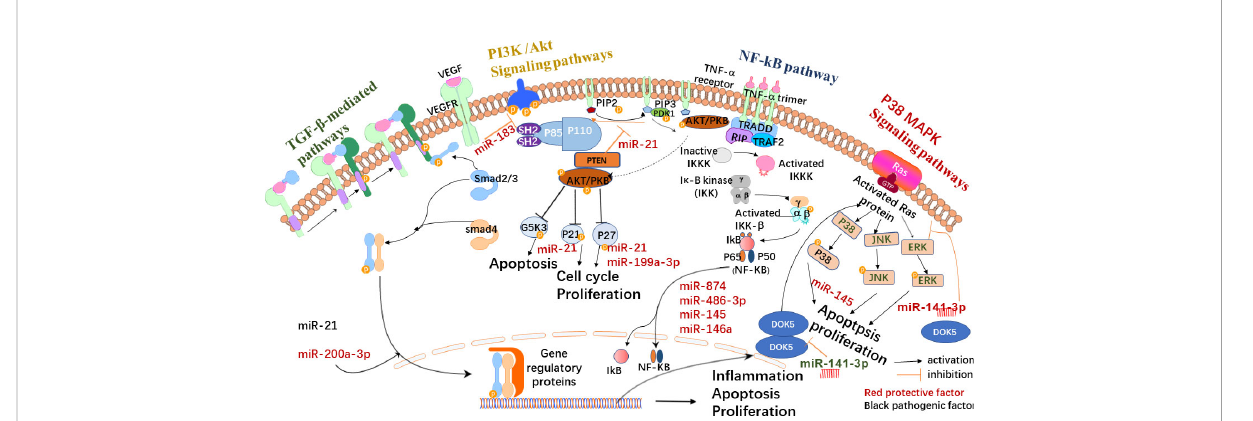
FIGURE 2 Possible exosome-mediated signaling pathways in DR. Exosomes are synthesized in various cells. Under physiological or pathological conditions, their carriers may change and participate in the formation of the collective pathological state. They may activate TGF- b , the signaling pathway that mediates the hemodynamics of individuals with PDR. By blocking TGF- b , the activation of the signaling pathway promotes cell proliferation and reduces apoptosis and the in fl ammatory response. Exosomes (such as miR-141-3p) may also inhibit retinal neovascularization by preventing the activation of the p38/MAPK signaling pathway. Exosomes can also be detected by the PI3K/Akt signaling pathway, which can induce vascular endothelial cell proliferation while preventing cell apoptosis, as well as cell proliferation and migration of the retinal pigment epithelium cell. The stimulation of the signaling system may also aid in the reduction of HG-induced cell proliferation, migration, and angiogenesis. In diabetic rats, the activity of the NF- k B signaling pathway rose dramatically, and inhibiting the NF- k B signaling pathway can reduce in fl ammation, apoptosis, and oxidative